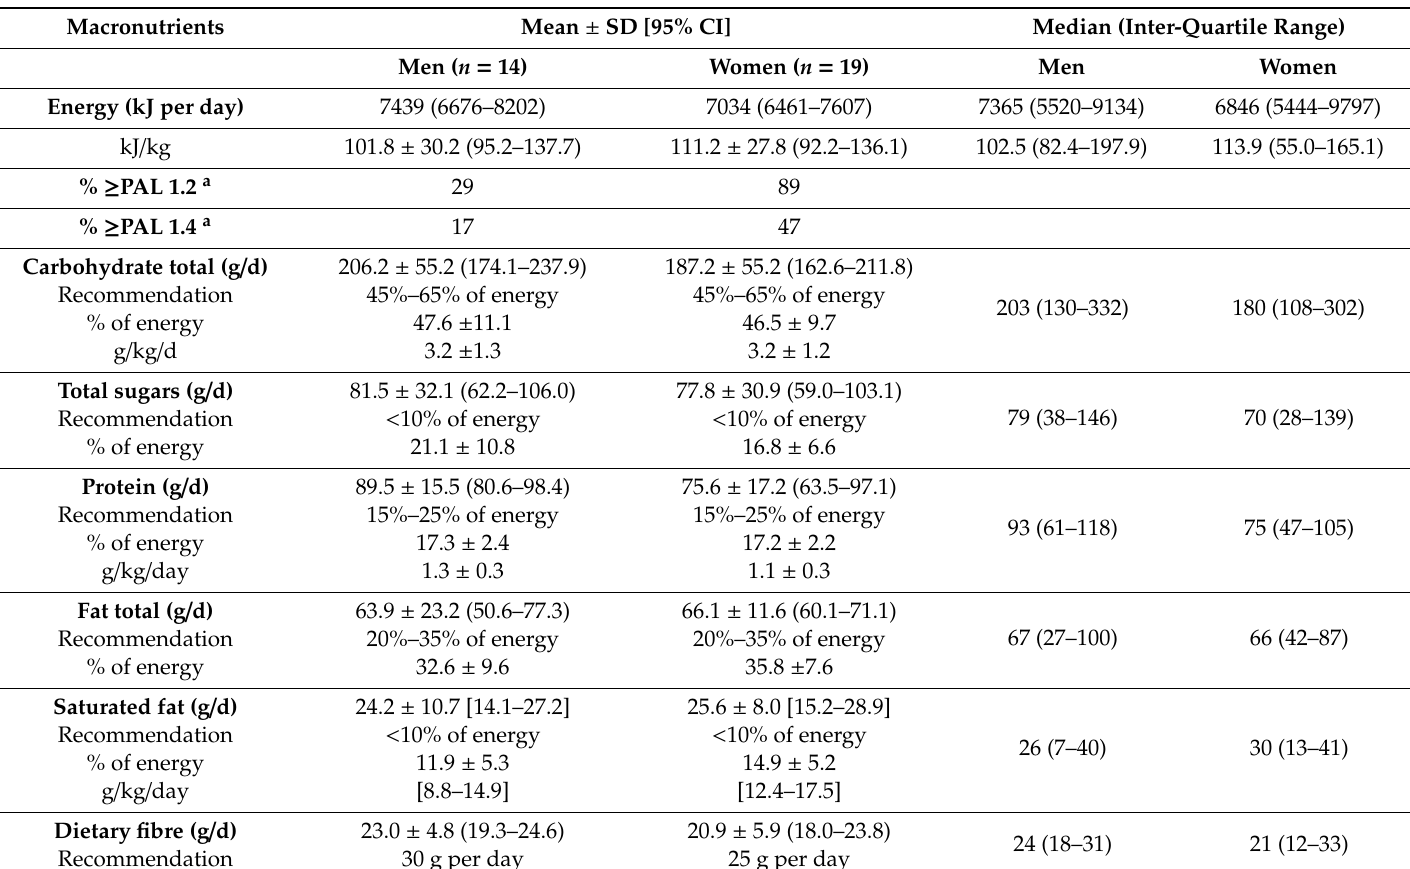
Table 2. Energy and macronutrient intake among men and women with intellectual